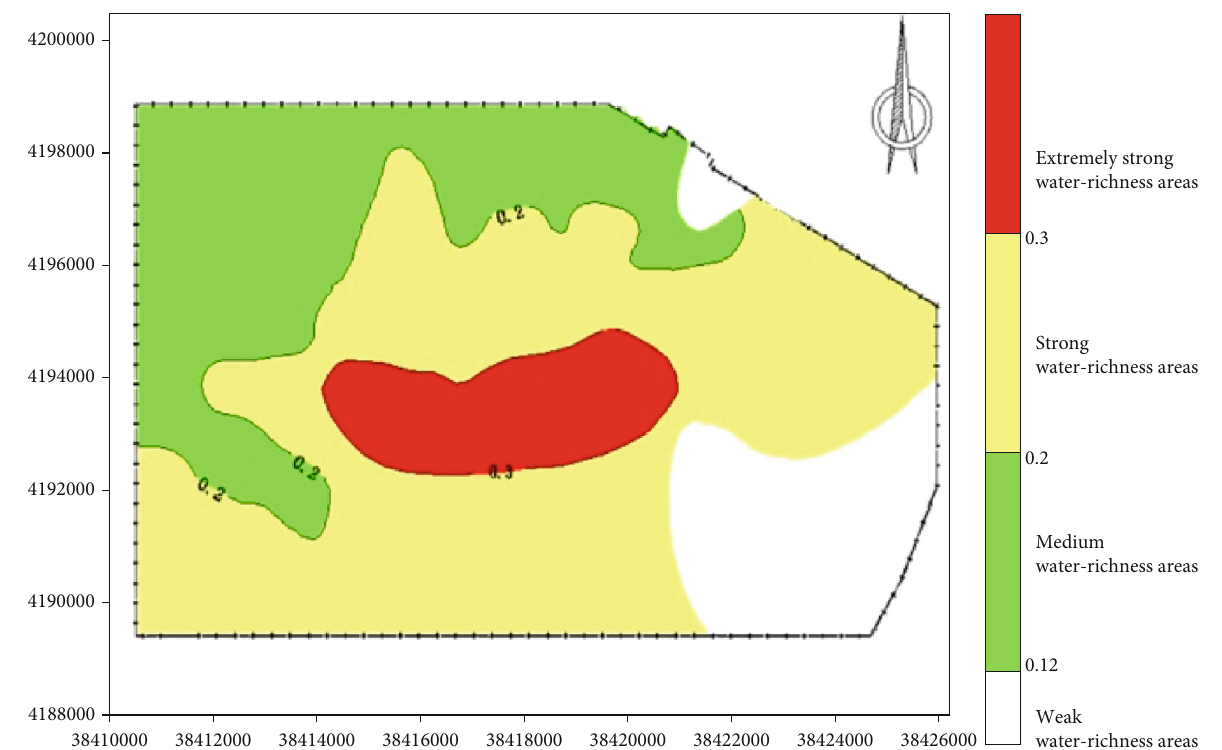
Figure 12: Water richness zoning map of the K